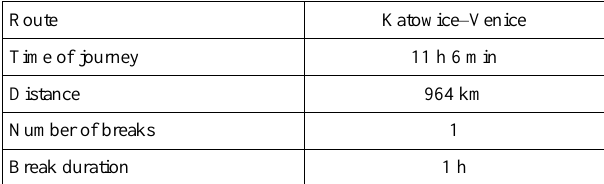
Table 3. Route details for Tesla Model 3 Long Range with the utilization of fastcharger [7] Route